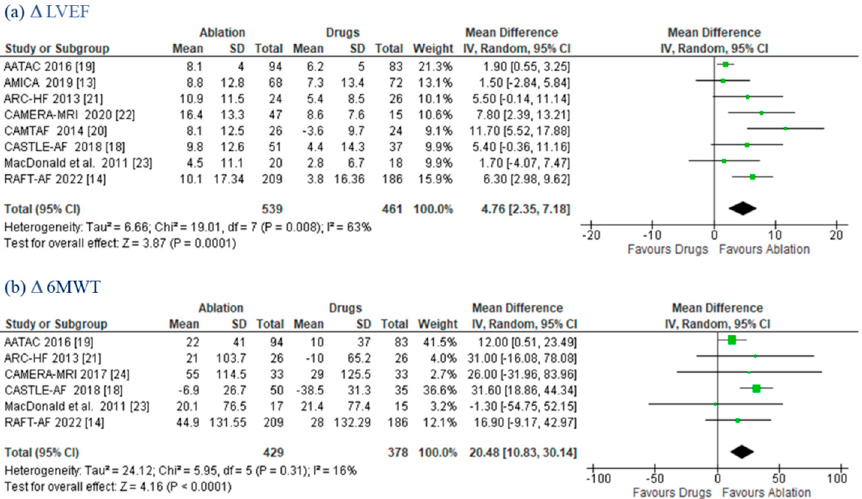
Figure 4. LVEF and 6MWT. Forest plots displaying mean differences in LVEF ( a ) and 6MWT ( b ) between the ablation and drug groups: 6MWT: 6-minute walk test; CI: confidence interval; LVEF: left ventricular ejection fraction; SD: standard deviation.